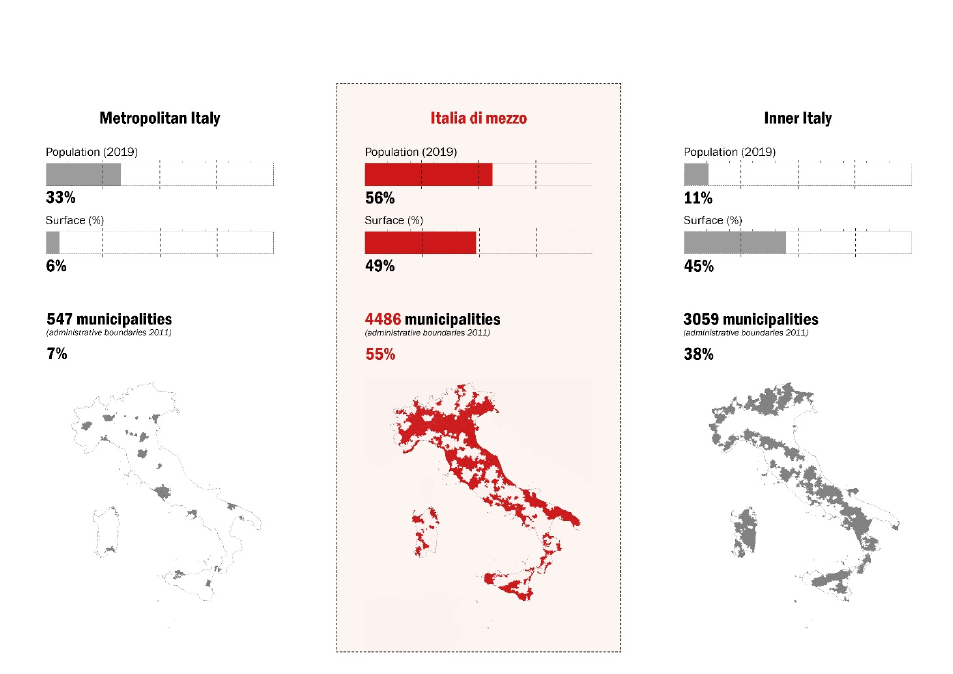
Figure 1: A significant portion of